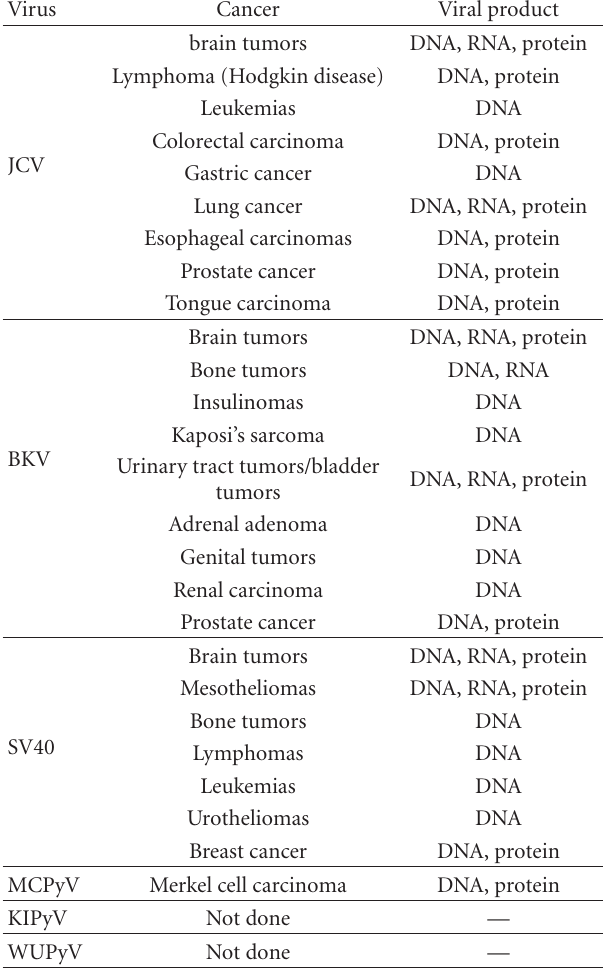
Table 2: Polyomaviruses-associated